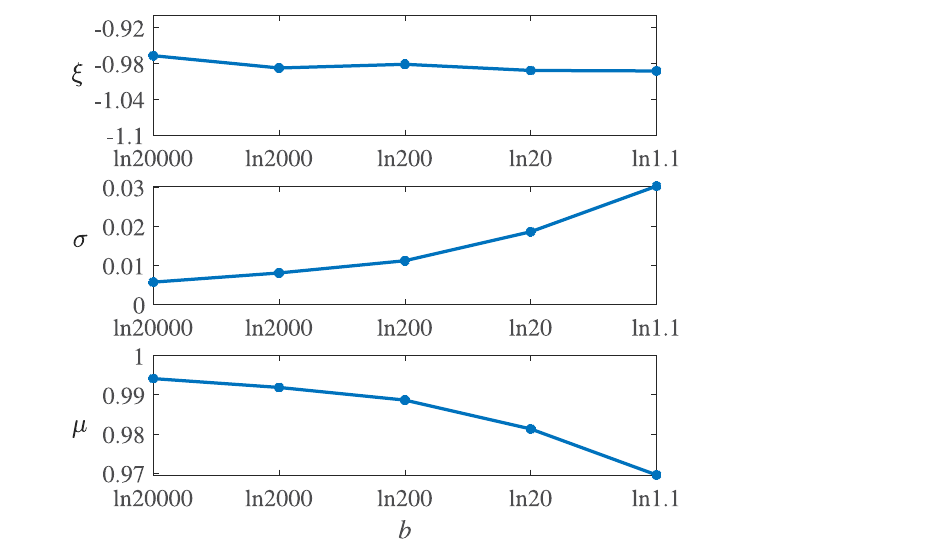
Fig 7. Parameters estimated of experiments in Table